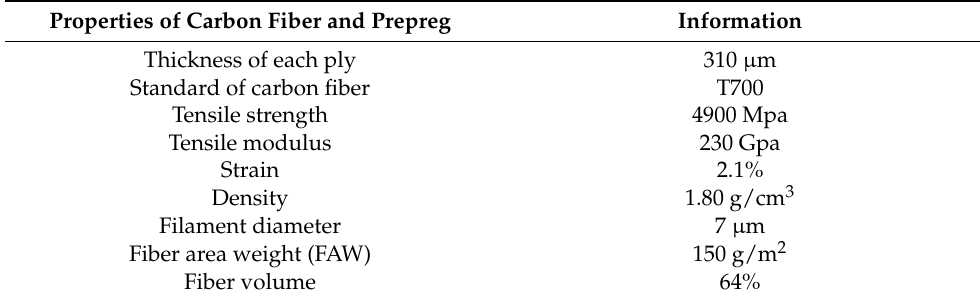
Table 2. Information on carbon fiber and prepreg [26].